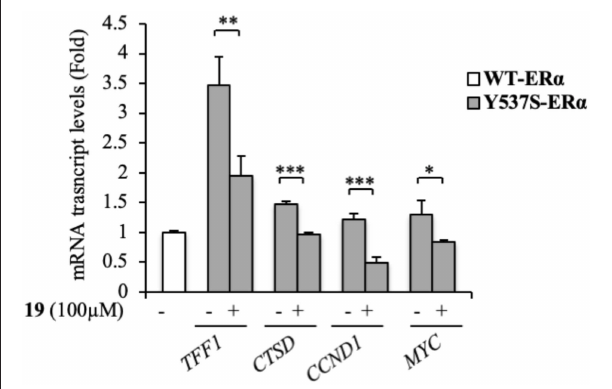
FIGURE 5 | Effects of compound 19 on ER α target genes in YFP-Y537S ER α expressing MDA-MB-231 breast cancer cells. Real time RT-PCR assay for Trefoil Factor 1 ( TTF1 ), cathepsin D ( CTSD ), cyclin D1 ( CCND1 ) and c-Myc ( MYC ) mRNA expression. The values represent the mean ± S. D. of three different experiments, each performed in triplicate. n. s., non-significant; * P < 0.05; ** P < 0.005; *** P < 0.0005.